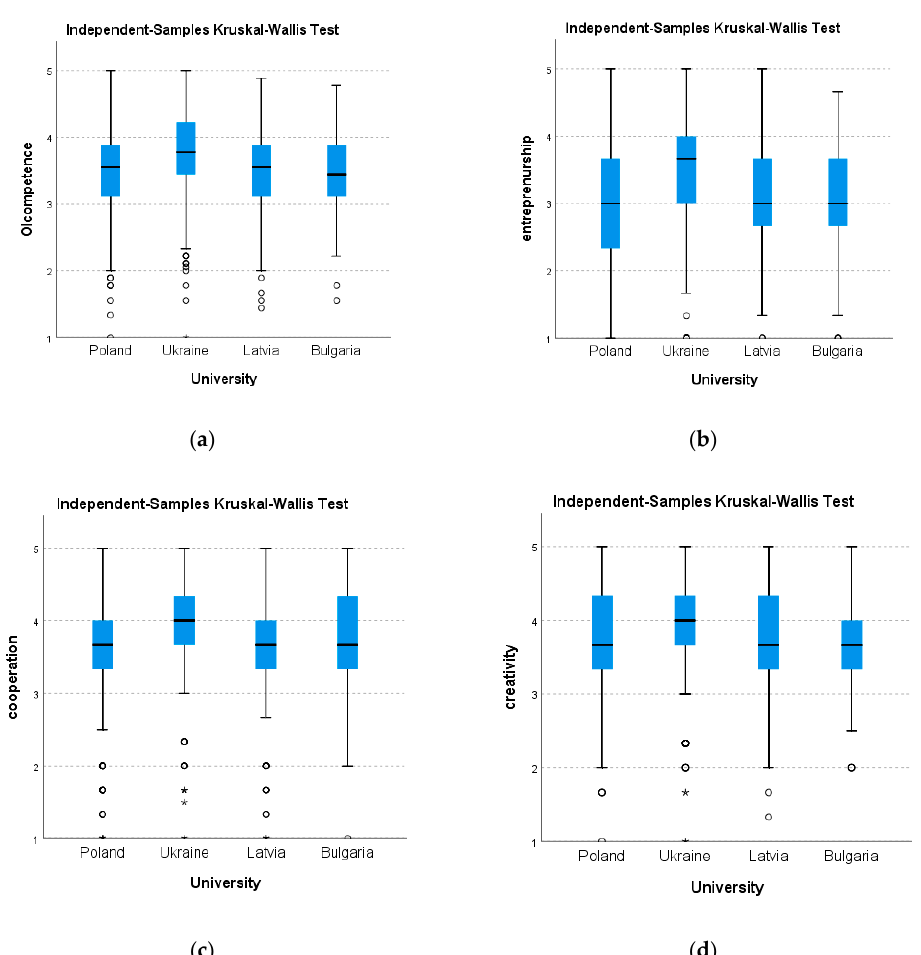
Figure 1. Kruskal–Wallis independent sample test boxplots of four categories scores including ( a ) OI competence score results; ( b ) entrepreneurship score results; ( c ) cooperation score results; ( d ) creativity score results.